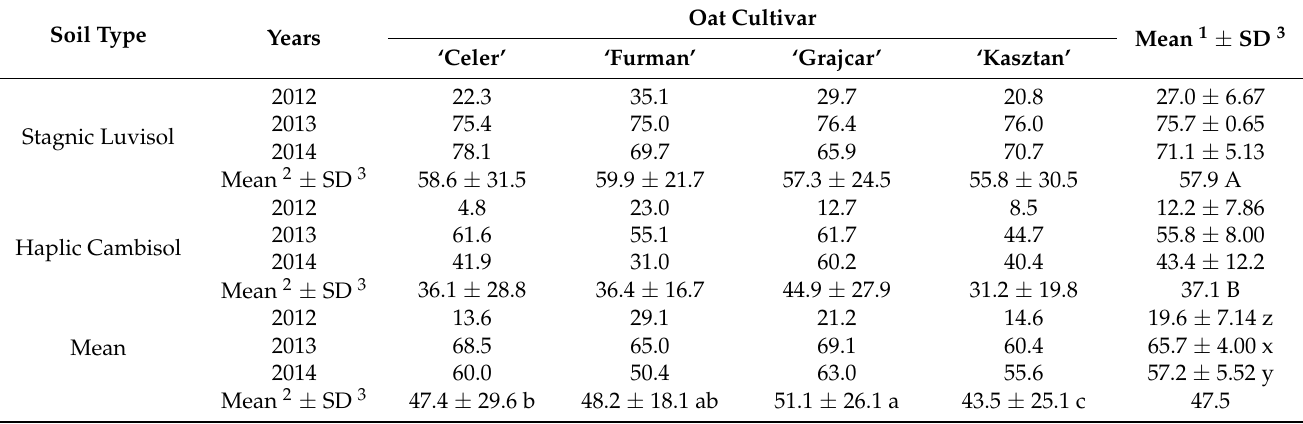
Table 8. Share (%) of common vetch seeds in the mixture depending on the soil type (factor I), oat cultivar (factor II), and study years (factor